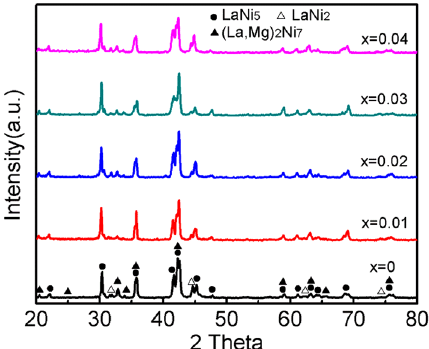
Fig. 1 X-ray diffraction patterns of the Re ( x = 0 ‒ 0.04)alloys